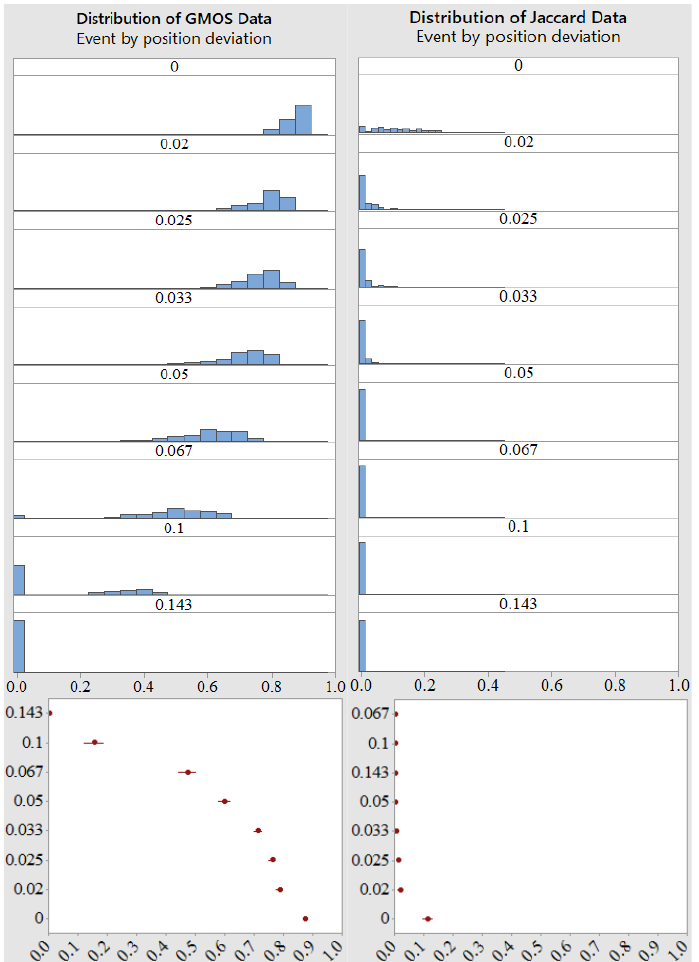
Figure 13. Comparison of event data by different constant position shift and corner disruption N ( 0.025,0.025 ) . Left side —general measure histograms and mean comparison. Right side —Jaccard index histograms and mean